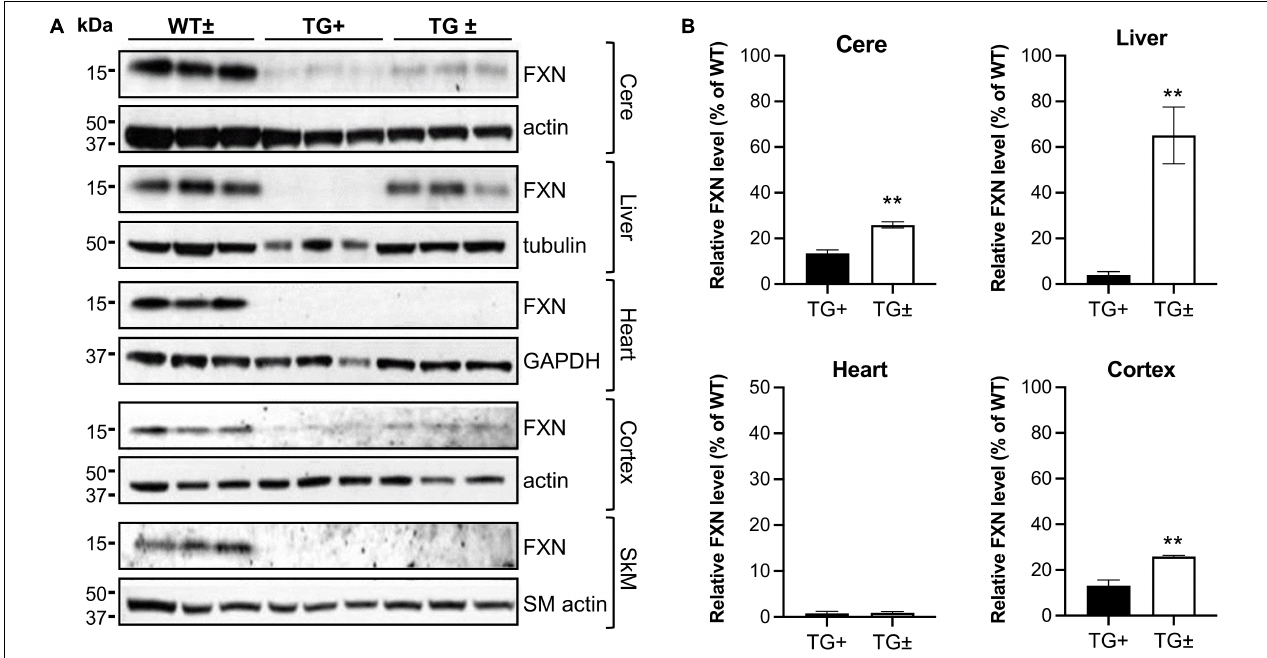
FIGURE 8 | Dox reversal partially reverses frataxin deficiency in a tissue-specific manner in FRDAkd mice. (A) Western blot analysis in WT ± , TG + , and TG ± mice of frataxin and tissue-specific internal loading controls (actin, SM-actin, GAPDH, and tubulin) in the cerebellum (cere), liver, heart, cortex, and skeletal muscle (SkM) ( n = 3 for WT ± , TG +, and TG ± ). (B) Quantification of frataxin levels normalized to tissue-specific internal controls (actin, SM-actin, GAPDH, tubulin). Frataxin levels were reported as a percentage of the wild type set to 100 percent. Quantification of SkM was zero in both TG + and TG ± (not shown) (Stats: WT, n = 3, TG +, n = 3, TG ± , n = 3, mean ± SEM, two-tailed, unpaired Student’s t -test, ** P <